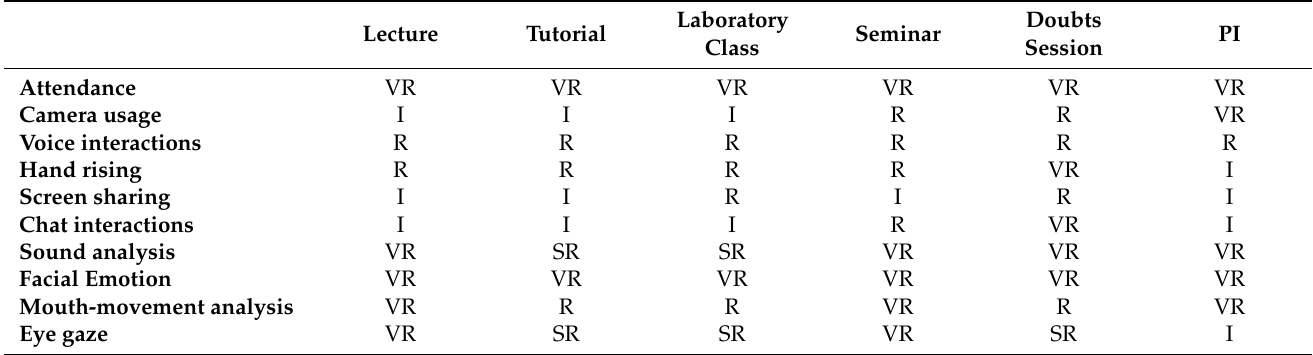
Table 18. Relevance of each category according to its weight in the teaching